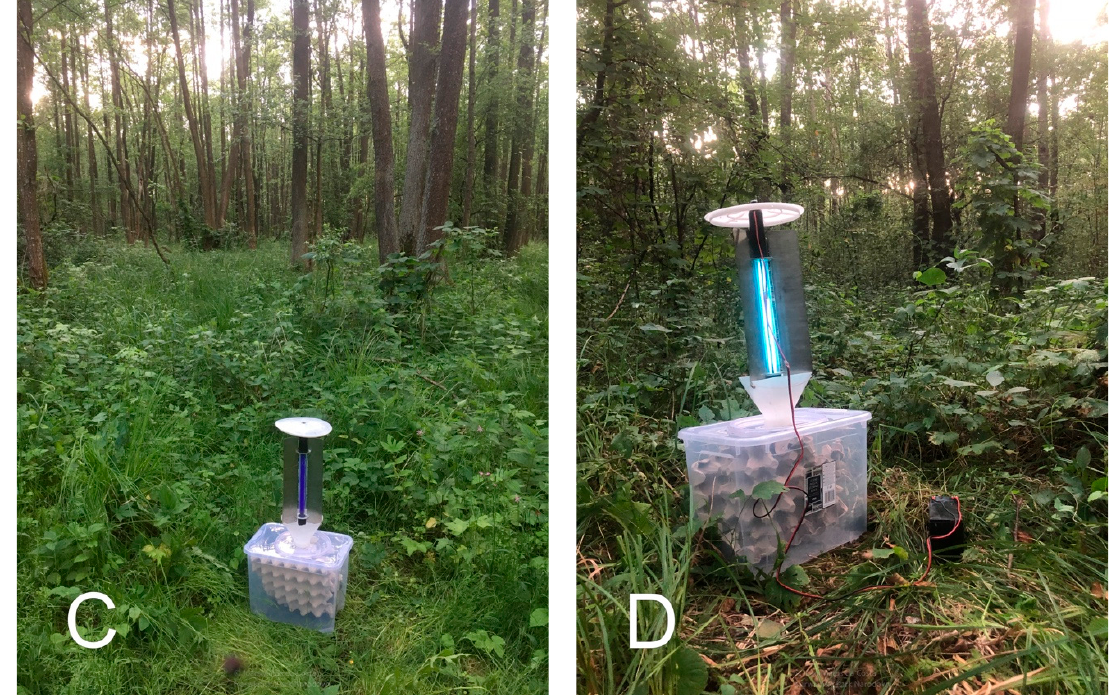
Figure A1. Representative pictures of the studied forest biotopes. A —QP biotope, B —SQP biotope, C —RN biotope and D —SRN biotope.